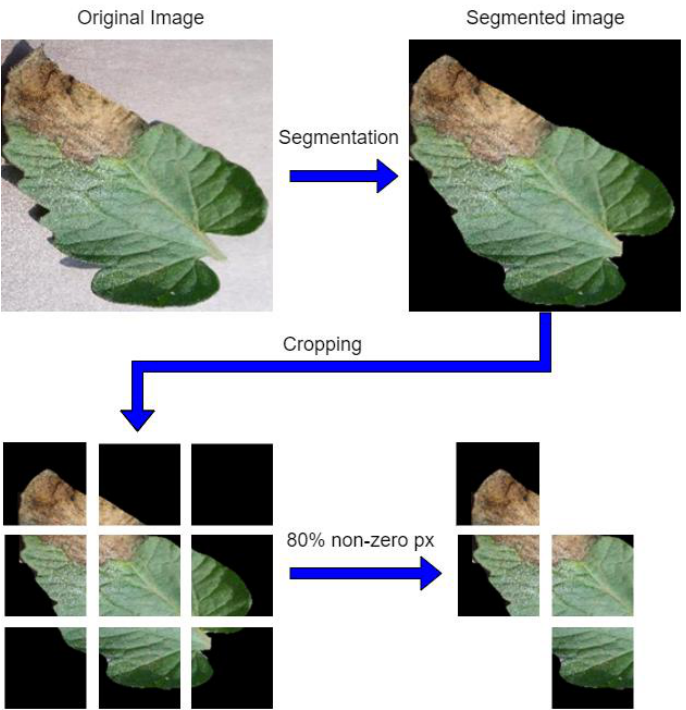
Figure 6. Example of cropping segmented images and selected tiles with more than 80% non-zero